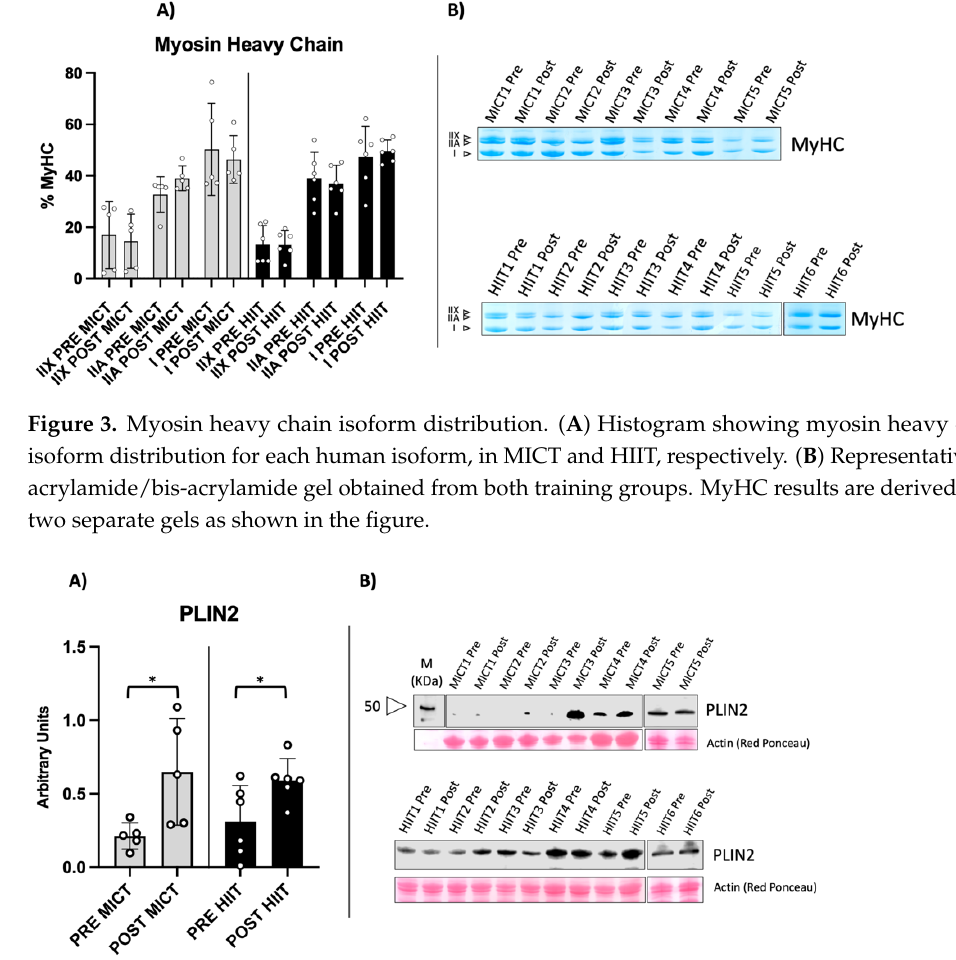
Figure 3. Myosin heavy chain isoform distribution. ( A ) Histogram showing myosin heavy chain isoform distribution for each human isoform, in MICT and HIIT, respectively. ( B ) Representative 8% acrylamide/bis ‐ acrylamide gel obtained from both training groups. MyHC results are derived from two separate gels as shown in the figure.